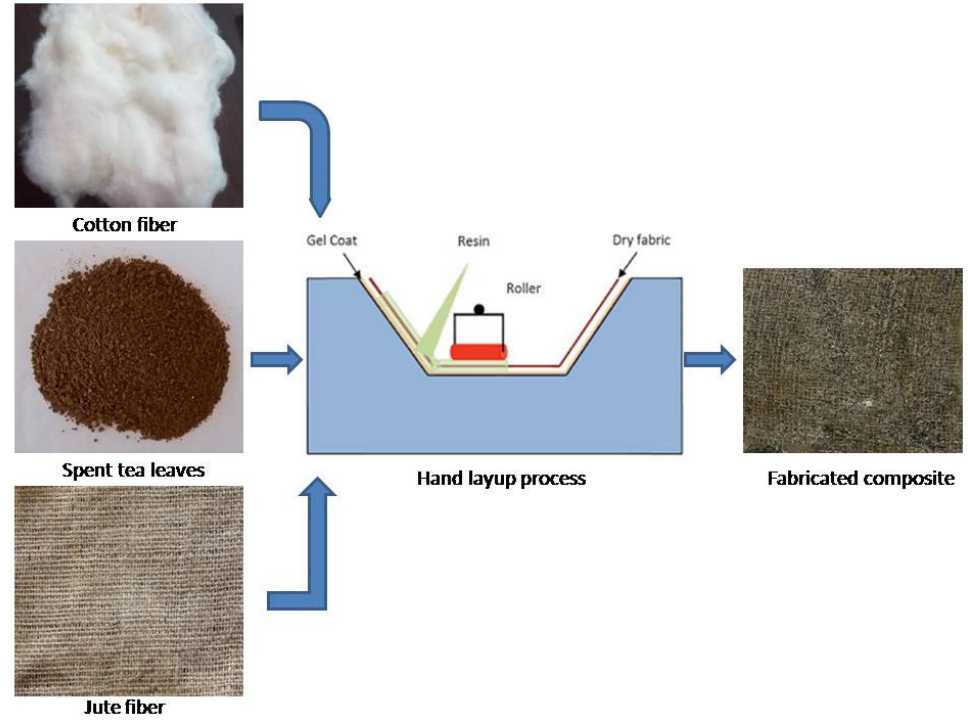
Figure 2. Fabrication process of the natural fibers and reinforced-particle-based composites.